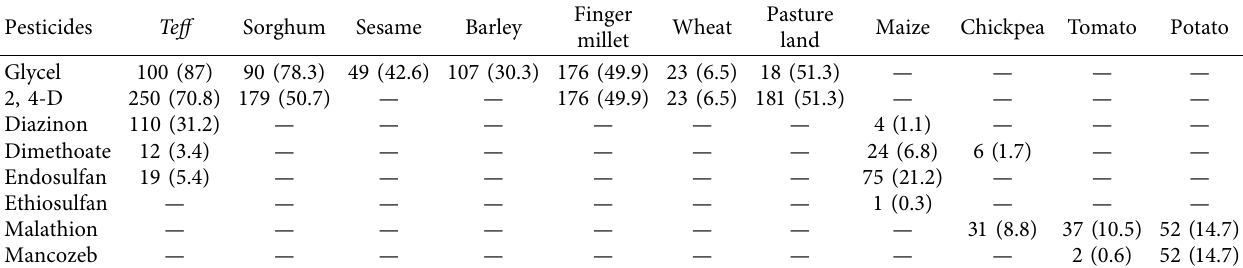
Table 6: Types of pesticides applied to diferent crops in the study area. Pesticides